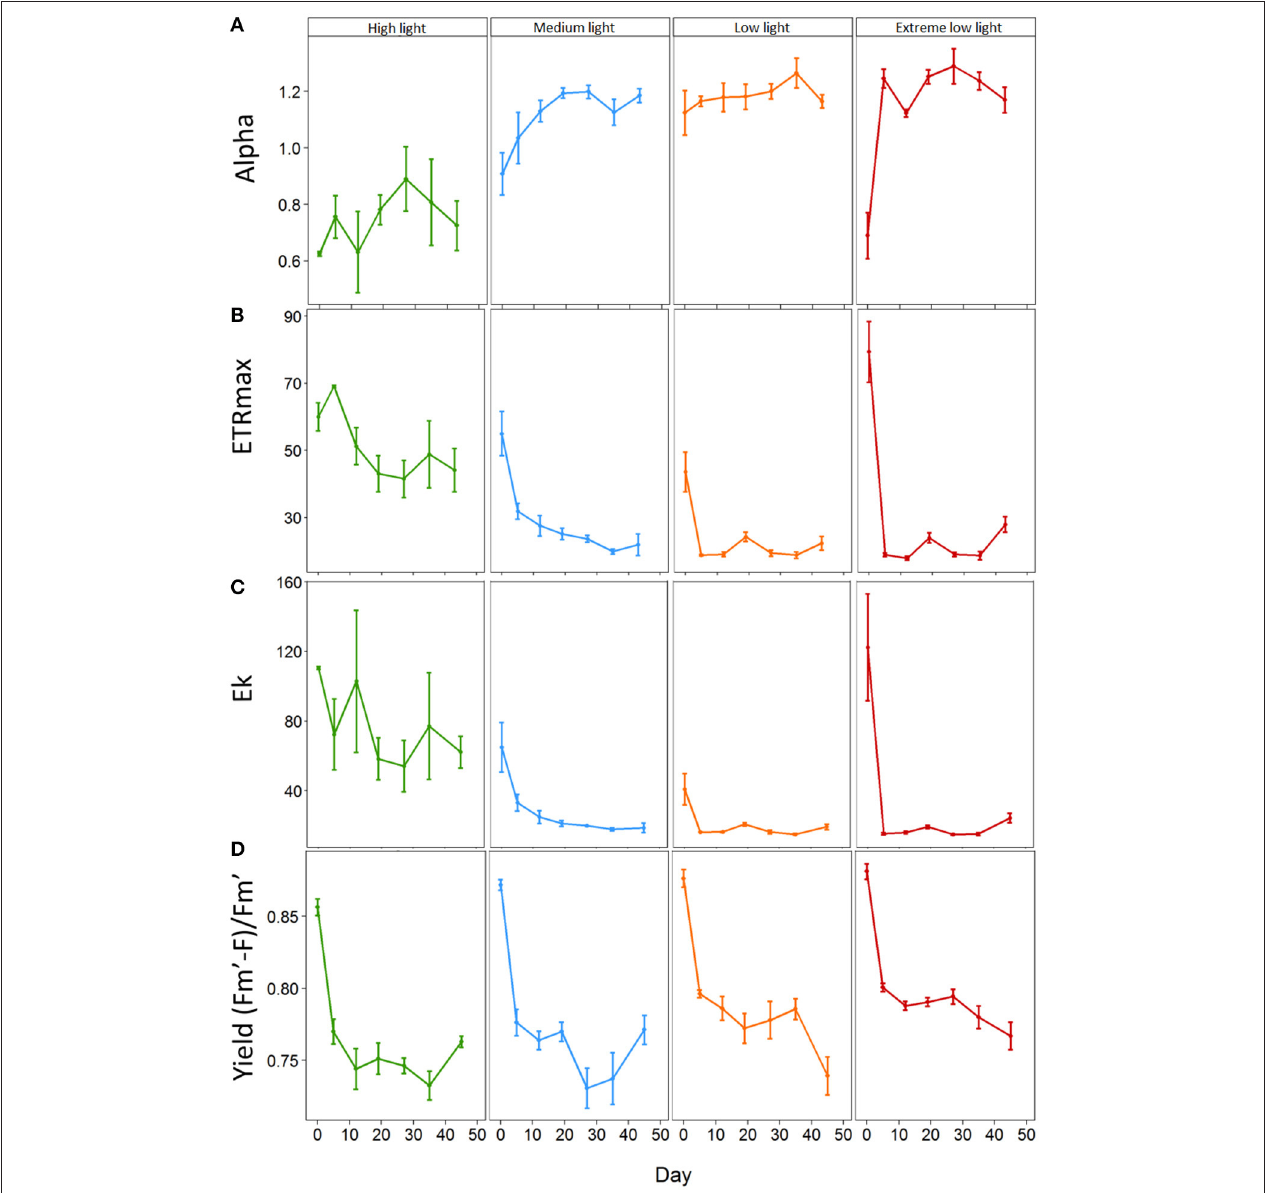
FIGURE 2 | Effect of light shading on the photosynthetic properties of Zostera marina over time measured by PAM fluorometry. Plants were kept in a flow through aquaria using natural filtered seawater under artificial light. (A) Alpha α , (B) Maximum electron transport rate (ETR max , µ mol electrons m − 2 s − 1 ), (C) Minimum saturation irradiance (E k , µ mol photons m − 2 s − 1 ) and (D) Effective quantum yield (F m ′ –F)/F m ′ . Values are mean ± SE, n = 4–5 (except HL and EL plants on day 0 where n = 2 and n = 3 respectively).